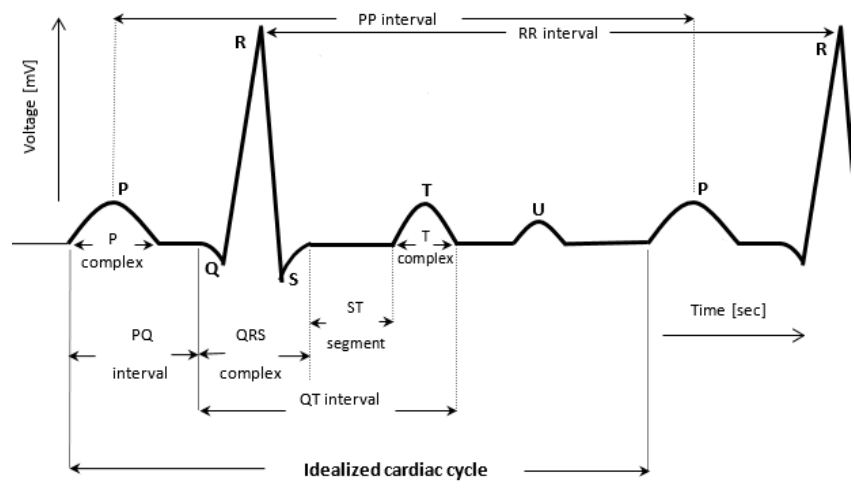
Figure 1. A part of an ECG waveform showing the cardiac cycle and its constituent patterns (illustrated on the basis of ECG signal description in